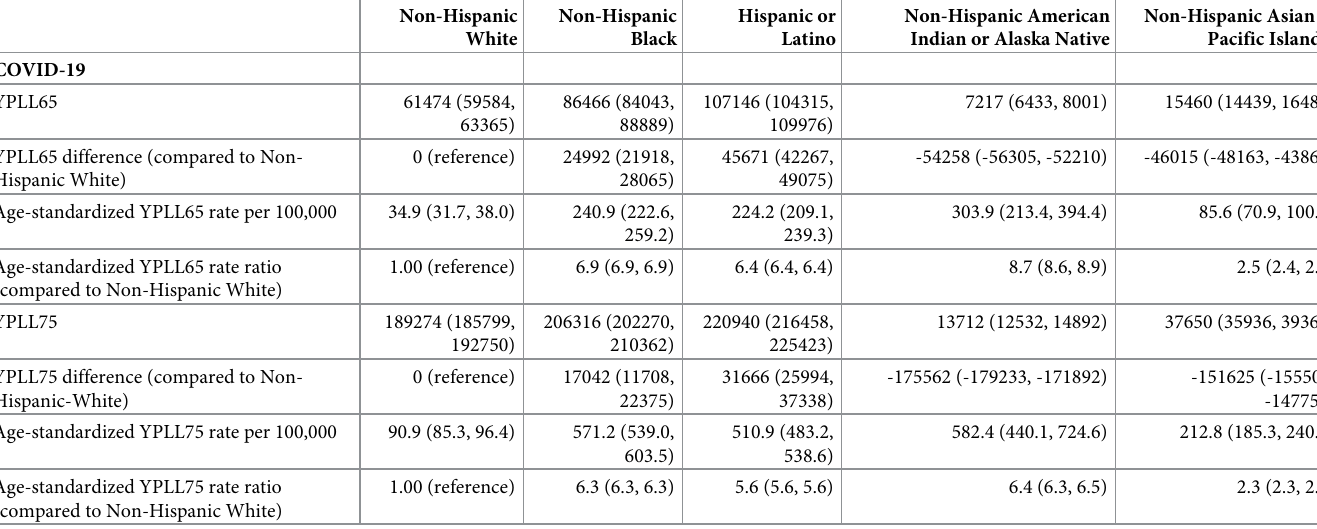
Table 2. Years of Potential Life Lost (YPLL) and age-standardized YPLL rates per 100,000 due to COVID-19 using age 65 and age 75 as cutoffs, with age-standard- ized YPLL ratios compared to Non-Hispanic whites as of July 22, 2020, United